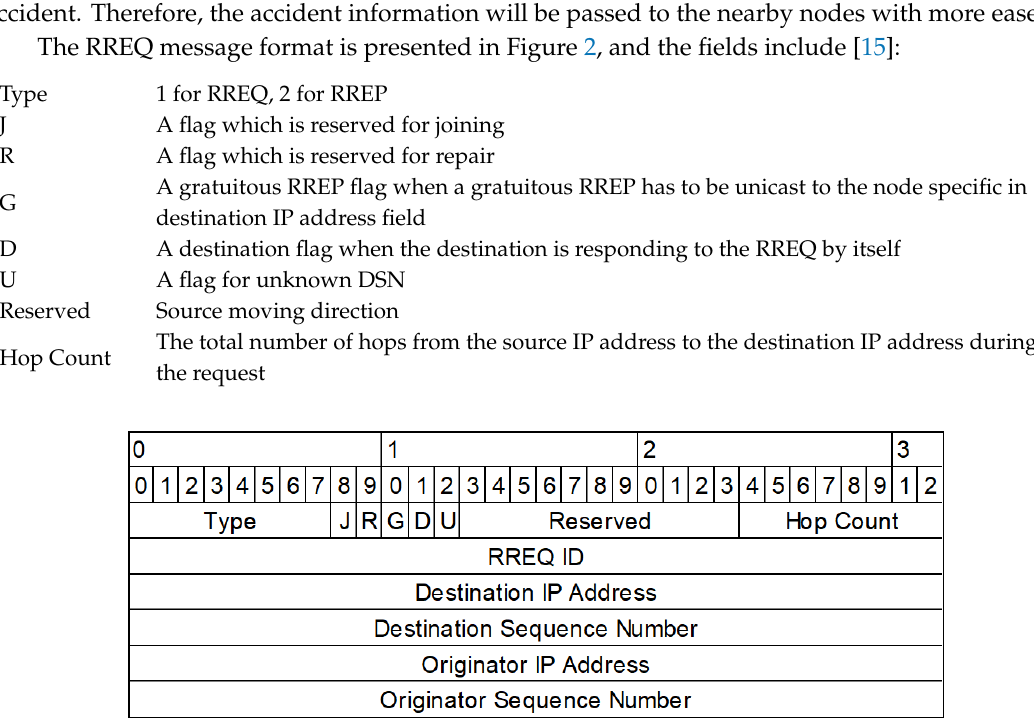
Figure 2. RREQ message